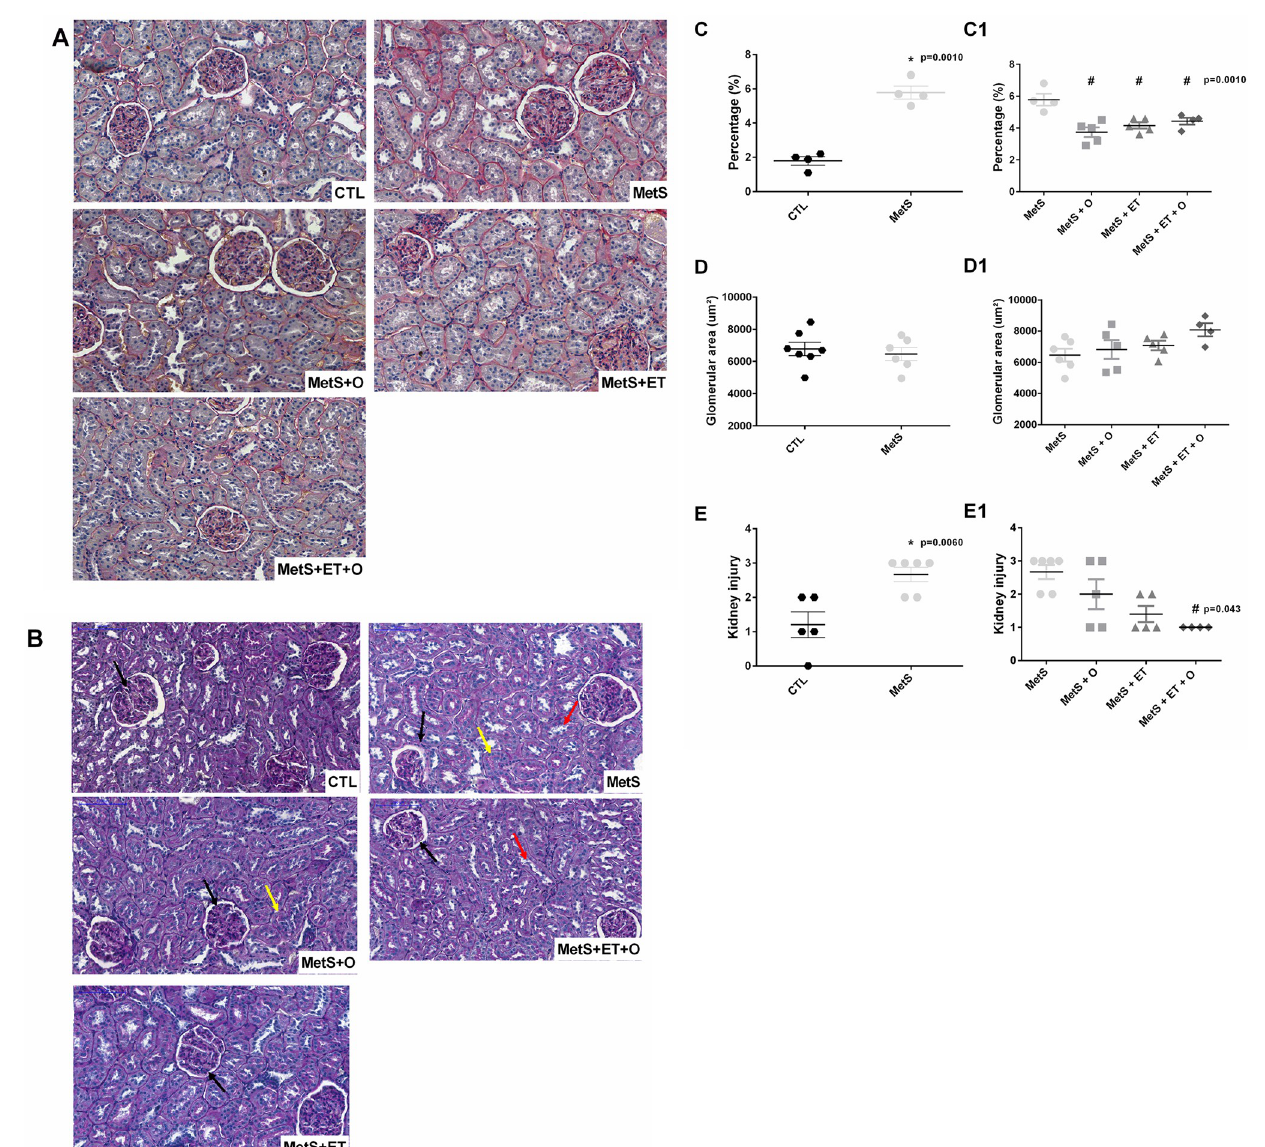
Fig 3. Renal histological analysis. (A) Photomicrographs representative of renal fibrosis, (B) Photomicrographs representative of other kidney injuries, (C/C1) Percentage of renal fibrosis (p = 0.0010 and p = 0.0010), (D/D1) Glomerular area, (E/E1) Degree of kidney injury (p = 0.0060 and p = 0.043). Black arrow– glomerular atrophy, Yellow arrow– tubular dilation, Red arrow– tubular degeneration. � vs. CTL; #vs. MetS. Statistic: One-Way ANOVA, p <